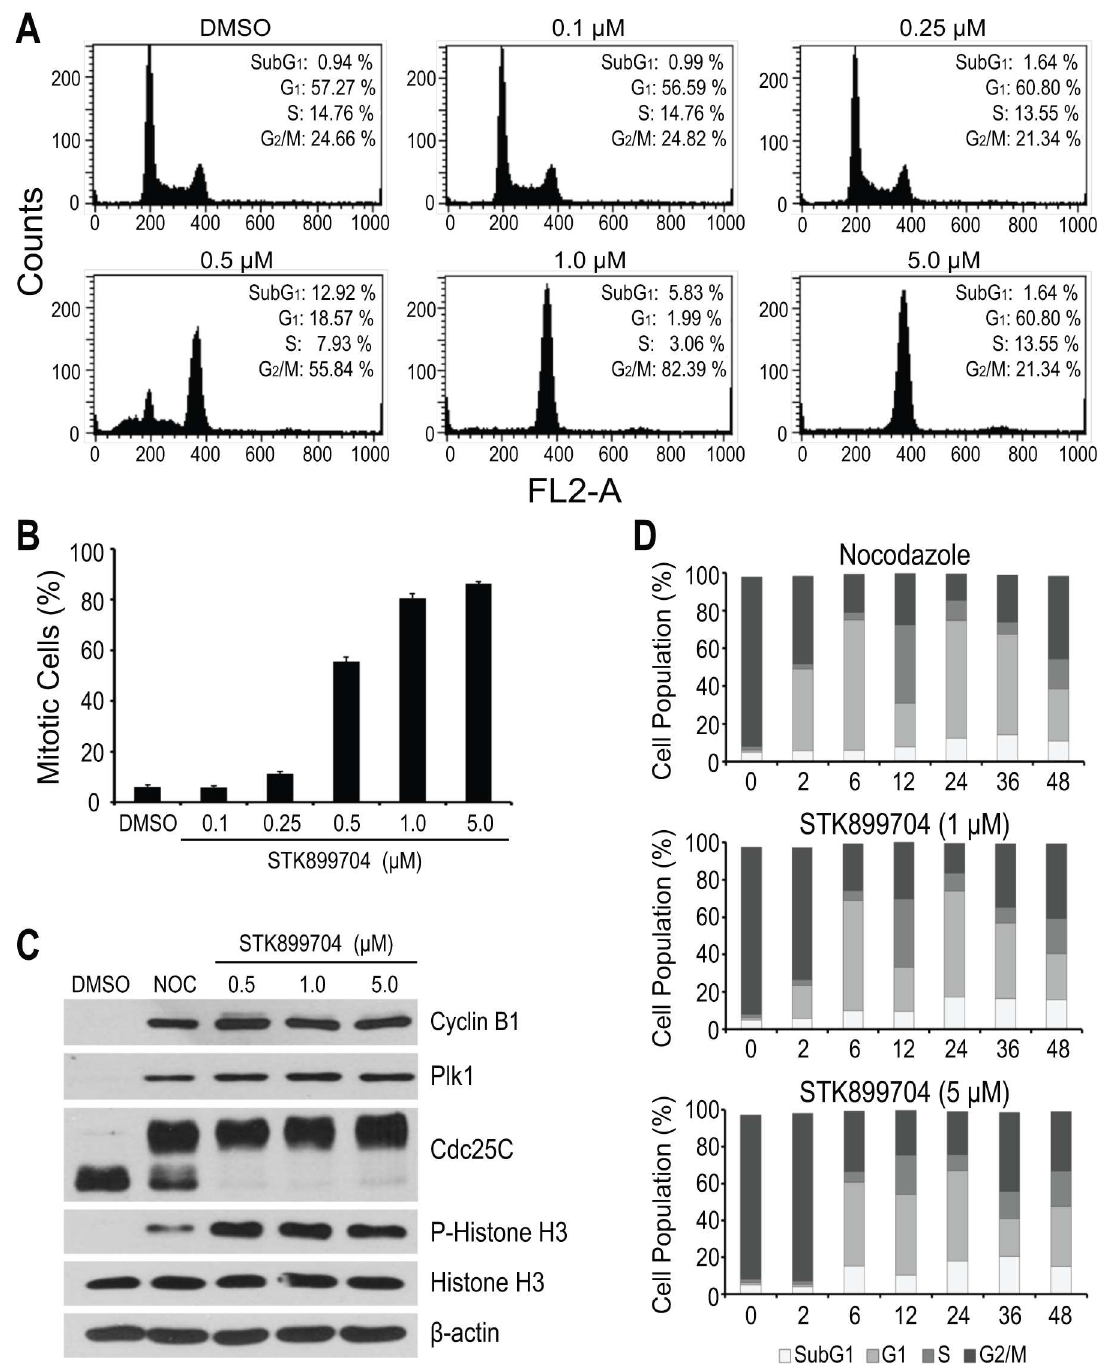
Fig 2. Antimitotic effect of STK899704. (A) Flow cytometric analysisfor cell cycle distribution. HeLa cells were treated with the indicatedconcentrations of STK899704 for 24 h. Treated cells were then stained with propidiumiodide(PI) and processed for cell cycle analysis.Data are representative of three independent experiments. (B) Mitotic index. HeLa cells were treated with the indicatedconcentrations of STK899704for 17 h. Cells were then stainedwith Hoechst 33342 and mitotic cells were counted. At least 100 cells were counted from the different regions. (C) Cell cycle related protein expression. HeLa cells were treated with DMSO control, 200 ng/ml nocodazole (Noc), or indicatedconcentrations of STK899704for 17 h. Treated cells were lysed and subjectedto immunoblot analysiswith antibodies againstcyclinB1, Plk1, Cdc25C,histone H3, and phospho- histoneH3 (S10). β -actin was used as a loadingcontrol. (D) Reversibleeffect of STK899704. HeLa cells were treated with